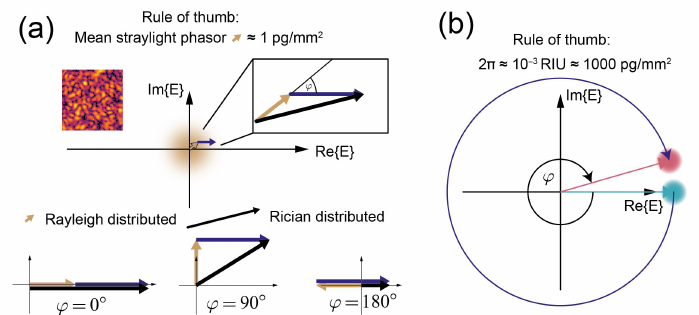
Figure 7. Rules of thumb for the lengths of typical stray light phasors of diffractometric biosensors as well as the refractometric phasors phase change per bound mass: ( a ) the stray light phasor length for optically smooth surfaces typically corresponds to 1 pg/mm 2 and is Rayleigh distributed. By interference in the far field, all roughness phasors form one random phasor sum with resultant phasors that form a fully developed speckle pattern with a negative exponential distribution of intensity. Thus, even a 10% magnitude error of the phasor results in only a 50 fg/mm 2 mass density error (Equation (10) and the mass density version of Equation (9)). In a direct measurement, the phase angle between stray light (yellow) and the phasor of the bound molecules (violet) is not known. The length of the resultant (black) phasor that is measured therefore follows a Rician distribution, and its length depends on the mutual orientation of stray light and signal phasors. The figure shows the resultant phasor’s length for three different phase angles. This uncertainty can be overcome by measuring the phase angle ϕ between the stray light phasor and the signal phasor by a phase reference (indirect technique). ( b ) In good refractometric biosensors, roughly 1000 pg/mm 2 corresponds to a phase change of 2 π . Thus, a measurement error of 10% will give rise to a 100 pg/mm 2 error in terms of mass